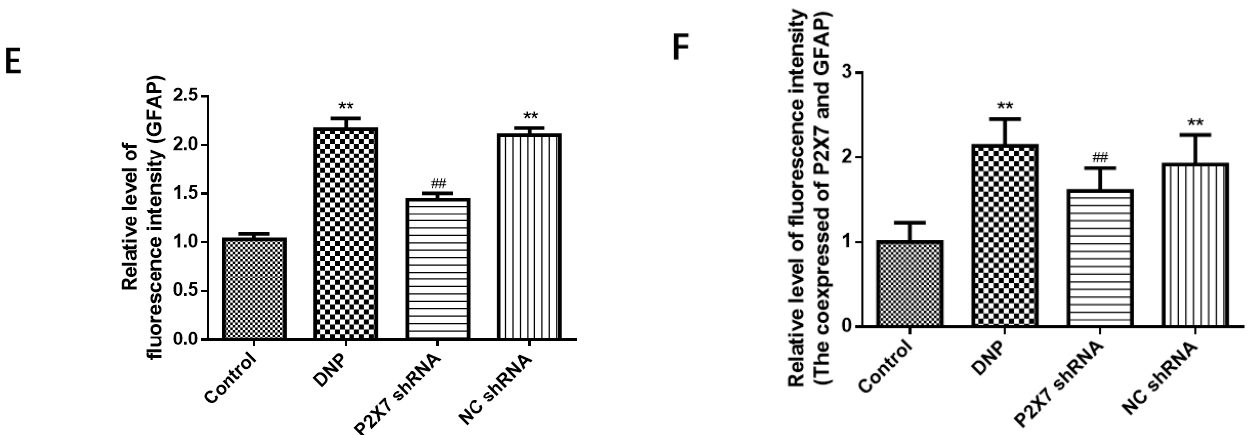
Figure 4. Measurement of P2X7 mRNA and protein levels in the DRG and co-expression levels of P2X7R with GFAP. ( A ) P2X7 mRNA. ( B ) SDS-PAGE of P2X7R protein in DRG of experimental rats in each group. ( C ) P2X7R protein expression in the DRG of each group was analyzed. ( D ) Co- expression of GFAP and P2X7R in DRG. ( E ) Relative fluorescence intensity levels of GFAP in each group. ( F ) Relative fluorescence intensity levels of GFAP and P2X7R co-expression. P2X7 mRNA, protein levels, and co-expression levels of P2X7R and GFAP in the P2X7 shRNA group were lower than in the DNP rats. Blue staining (DAPI) marks the nucleus, green staining (GFAP) marks activated SGCs, and red staining marks P2X7R. The scale bar represents 50 µ m; data are shown as mean ± SEM based on at least three independent experiments, n = 6; ** p < 0.01 versus the Control group; ## p < 0.01 versus the DNP group.